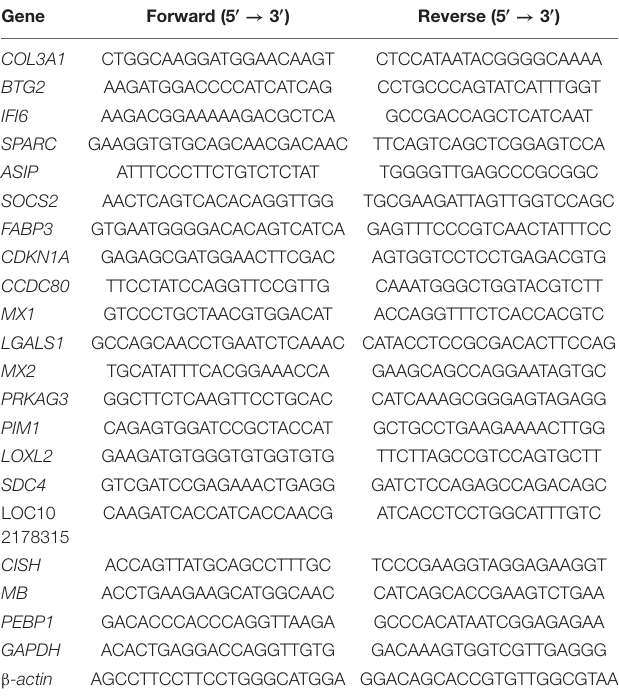
TABLE 2 | The information of PCR primer used for RT-qPCR. Gene Forward (5 (cid:48) → 3 (cid:48) ) Reverse (5 (cid:48) → 3 (cid:48)